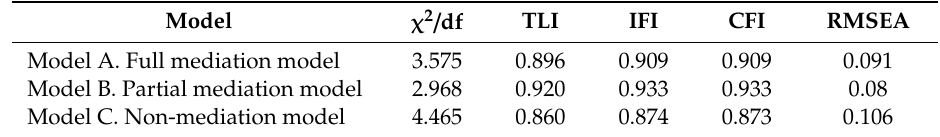
Table 2. Results of the structural equation